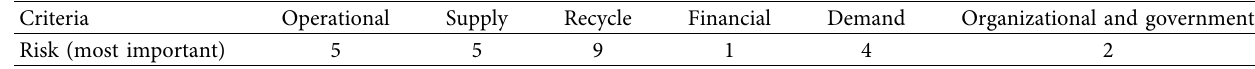
Table 4: Pairwise comparison of the most important criterion with other criteria.